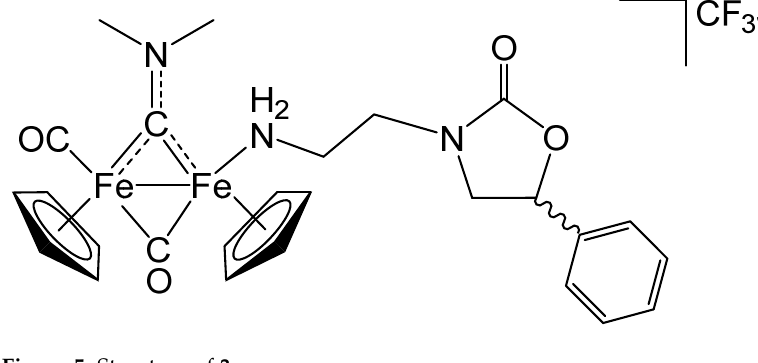
Figure 5. Structure of 3 .